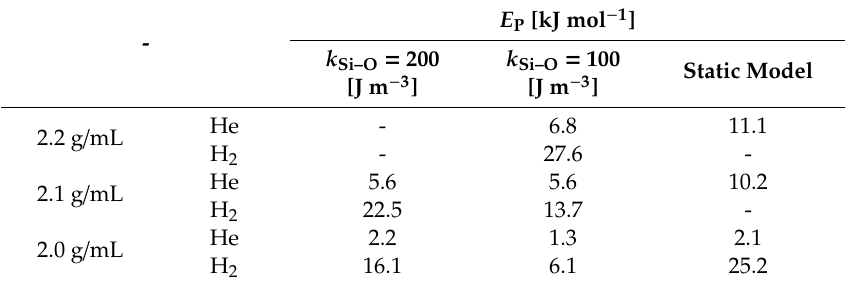
Table 4. Activation energy of He and H 2 permeation for virtual silica membrane models.